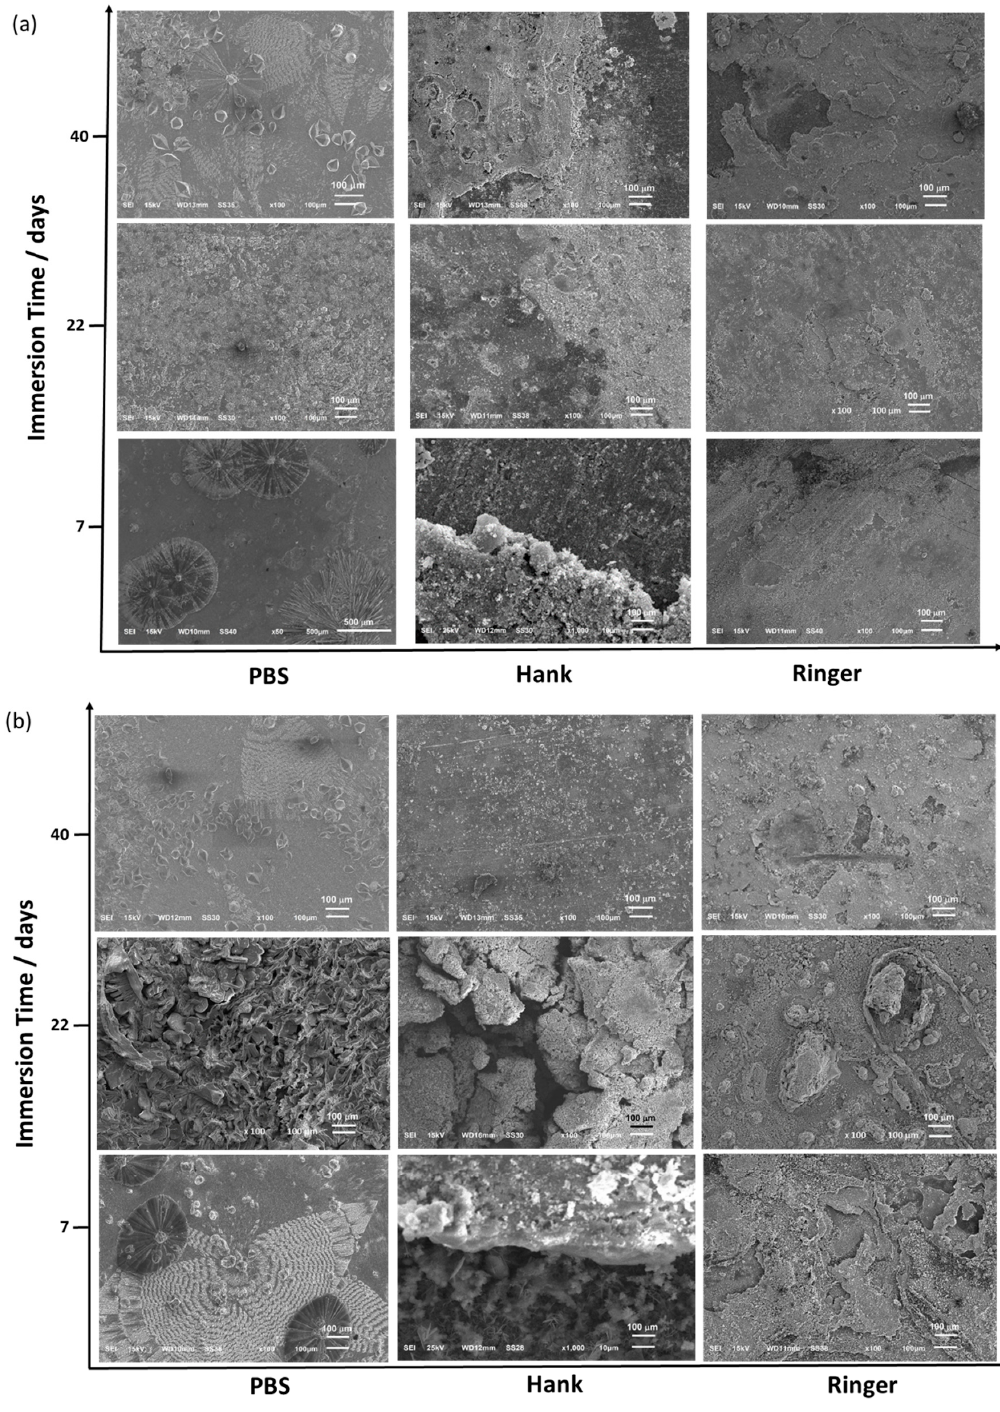
Figure 7. SEM images of Zn coatings ( a ) and Zn / AgP ( b ) (0.30 wt.% Ag) composite coatings obtained after different immersion times in different physiological solutions at 37 °C.